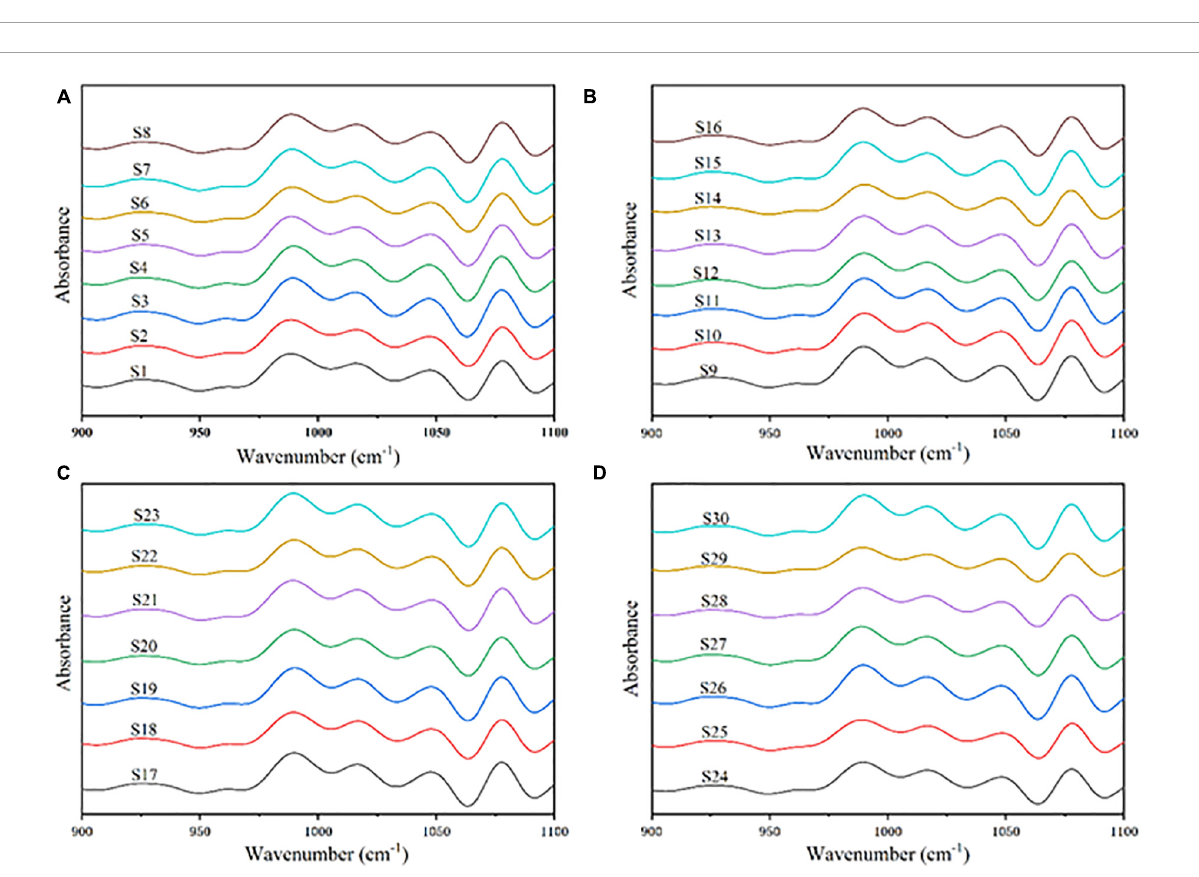
FIGURE4 (A) Deconvoluted FTIR spectra from S1 to S8. (B) Deconvoluted FTIR spectra from S9 to S16. (C) Deconvoluted FTIR spectra from S17 to S23. (D) Deconvoluted FTIR spectra from S24 to